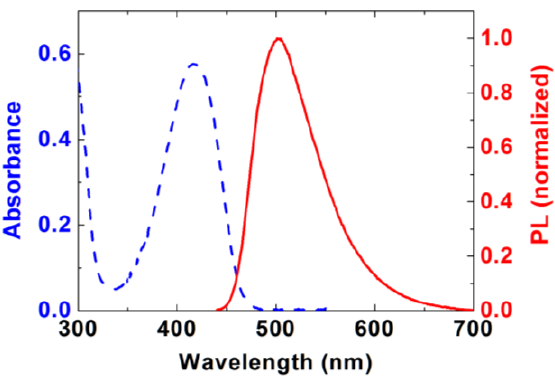
Figure 3. Absorption (dashed line) and PL spectra (solid line) of a 340 nm thick PIM